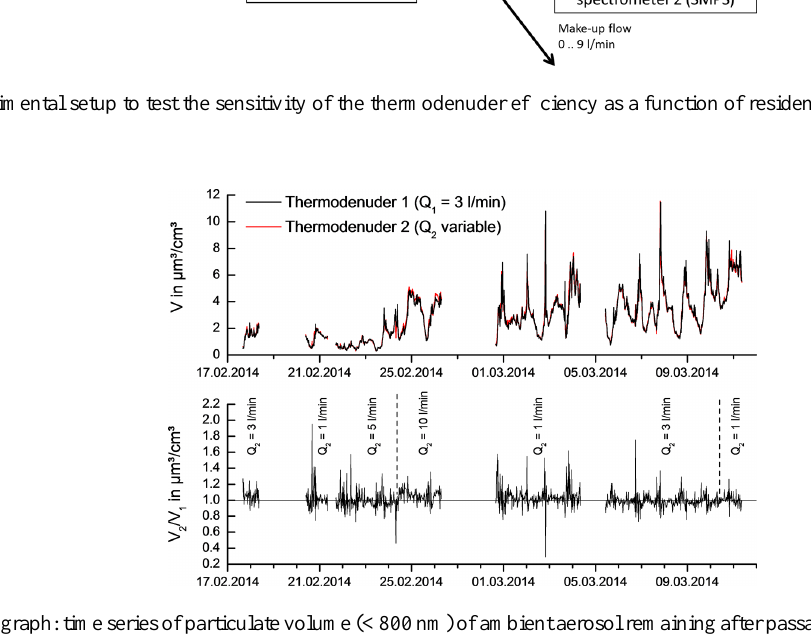
Figure A2. Upper graph: time series of particulate volume (<800nm) of ambient aerosol remaining after passage through the thermodenuders at 300 ◦ C. Bottom graph: ratio V 2 /V 1 between the volumes remaining downstream of the thermodenuders.